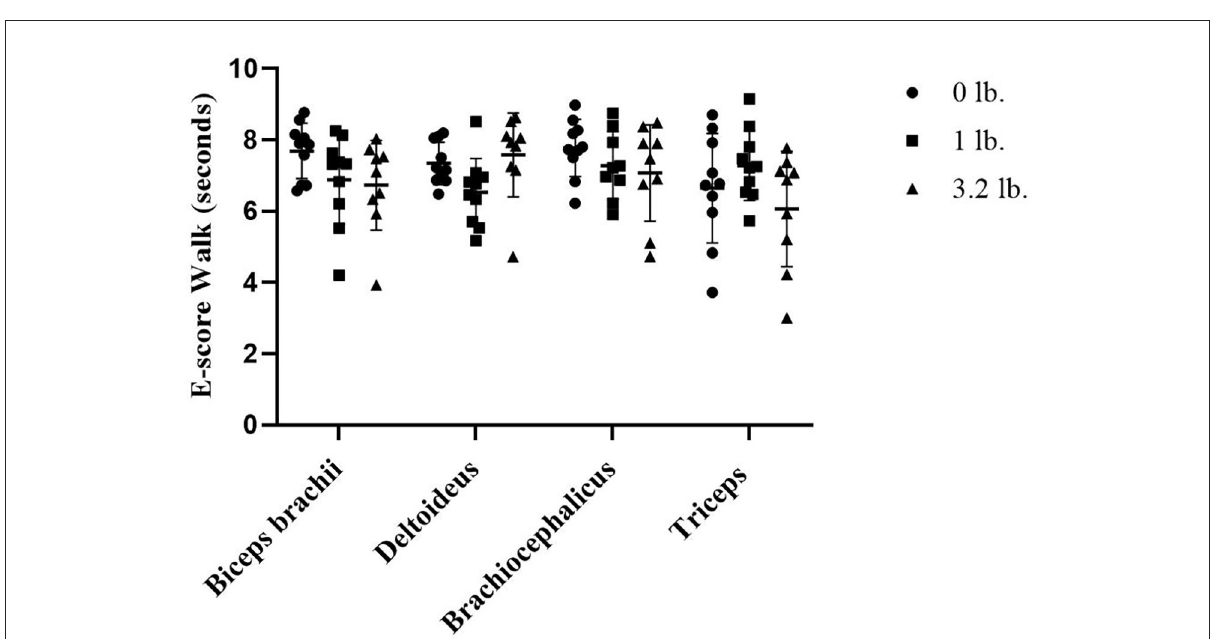
FIGURE3 Acoustic myography (AMG) efficiency score (E-score) at walk in the biceps brachii, deltoideus, brachiocephalicus, and triceps ( N =